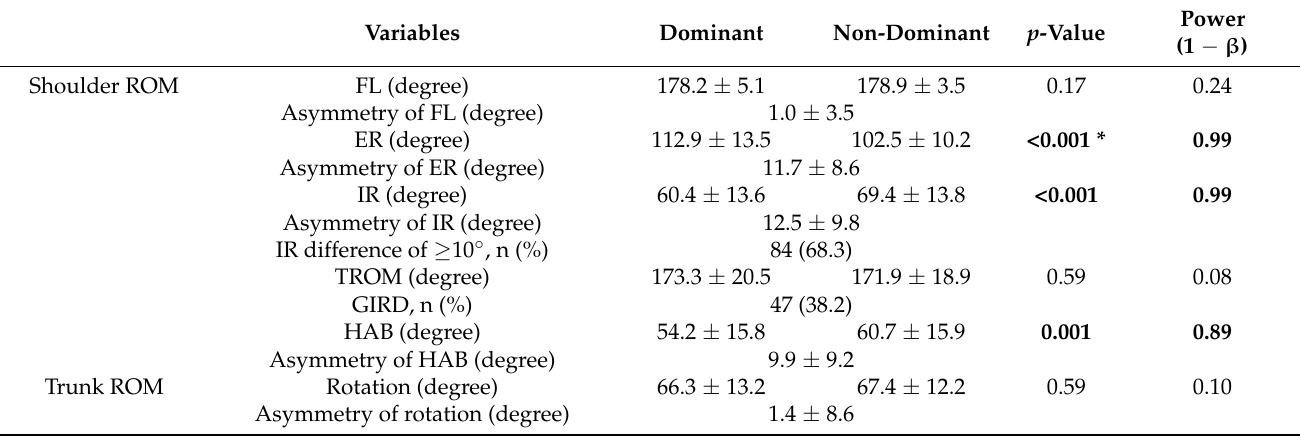
Table 2. Participants' shoulder and trunk ROM (n =